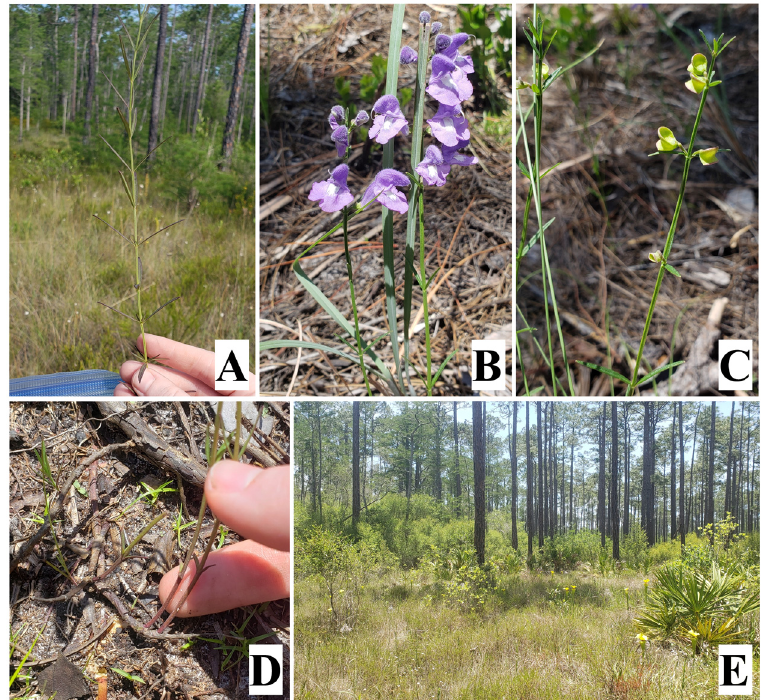
Figure 1. Scutellaria floridana plants, flowers, fruits, and habitat. ( A ) vegetative growth, ANF, ( B ) flowers, BRWMA, ( C ) fruits, BRWMA, ( D ) rhizome, BRWMA, and ( E ) typical habitat of S. floridana , ANF.